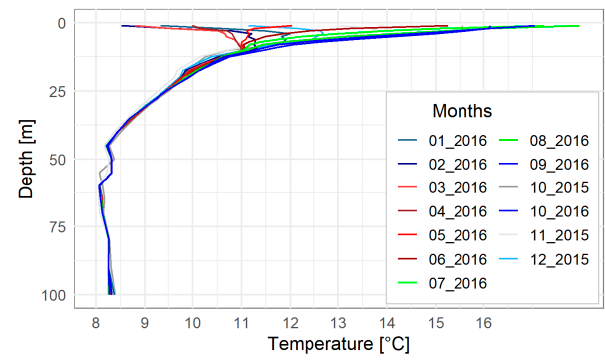
Figure 2. The undisturbed ground temperature